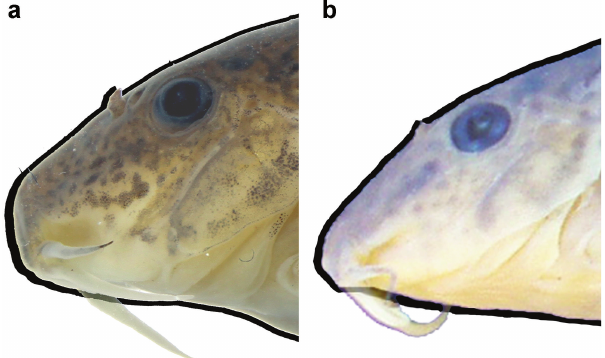
Fig. 2. Lateral view of head, left side, showing the snout profile of Scleromystax reisi , holotype, MCP 49070, 49.3 mm SL (a), and S. salmacis , holotype, MCP 38388, 36.7 mm SL (b; modified from Britto & Reis, 2005: fig.